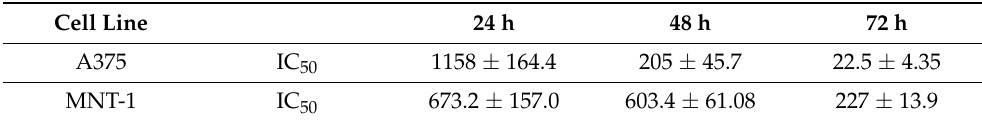
Table 1. Inhibitory concentrations (IC 50 ) obtained for 24, 48 and 72 h DTIC exposure. Values are expressed in μ g/mL. Data are presented as the mean ± standard error.